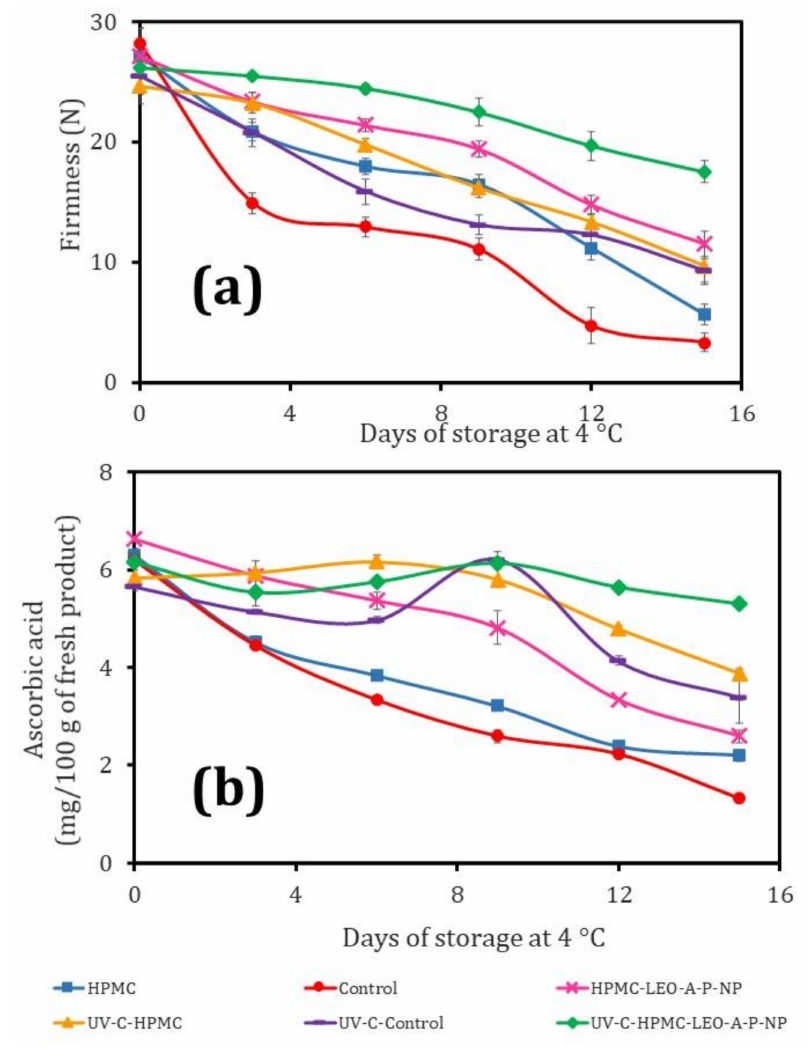
Figure 3. ( a ) Firmness changes in fresh cucumber in relation to storage time at 4 ◦ C; ( b ) ascorbic acid modification in fresh cucumber in relation to storage time at 4 ◦